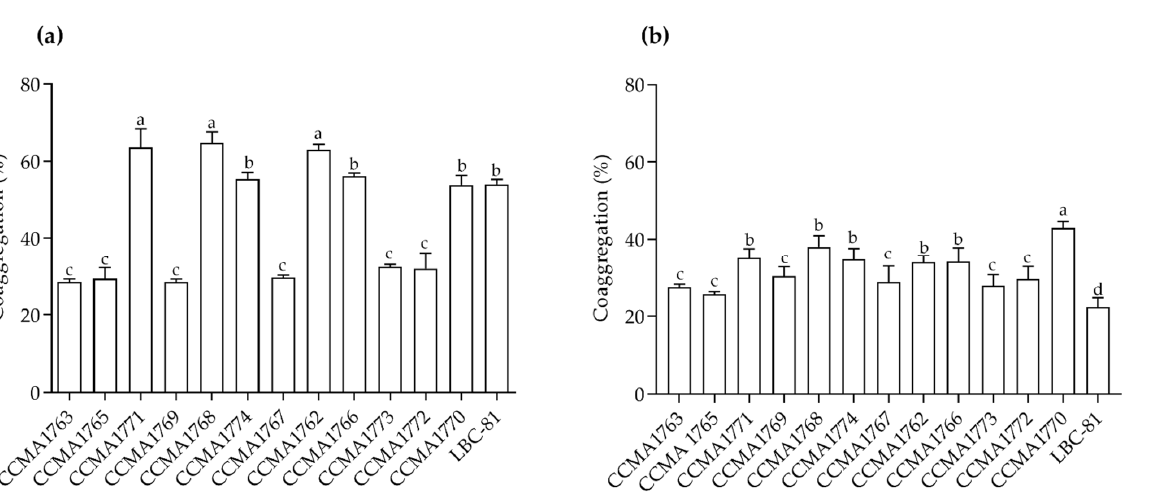
Figure 3. Percentage (%) coaggregation of LAB isolates with pathogenic microorganisms: ( a ): coag- gregation with Salmonella Enteritidis ATCC 564; ( b ): coaggregation with Escherichia coli (EPEC) CDC 055. Bar indicates SD. Bars followed by different superscript letters differ significantly ( p < 0.05) by the Scott–Knott test.